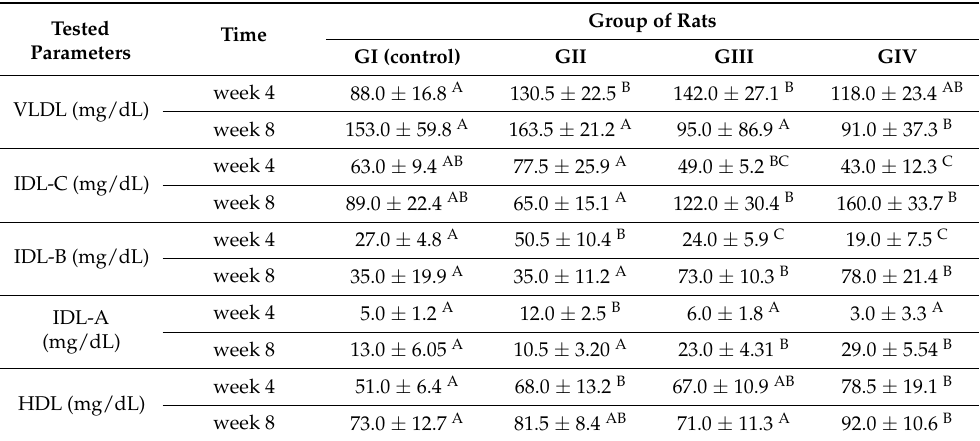
Table 4. Serum lipid concentrations as determined using the Lipoprint ® LDL System. Tested Parameters